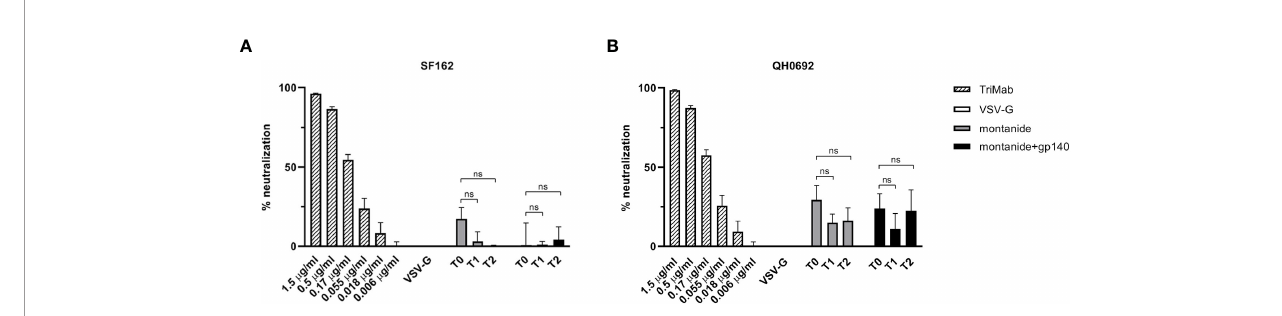
FIGURE 3 | HIV-SF162 (A) and HIV-QH0692 (B) pseudoviruses-blocking activities of C57BL/6 B6 EAE mice 7 (T1) and 14 (T2) days after immunization with montanide alone or in combination with gp140, compared to time before immunization (T0). All p-values were calculated using Student ’ s t test assuming unequal variance (ns, not signi fi cant).